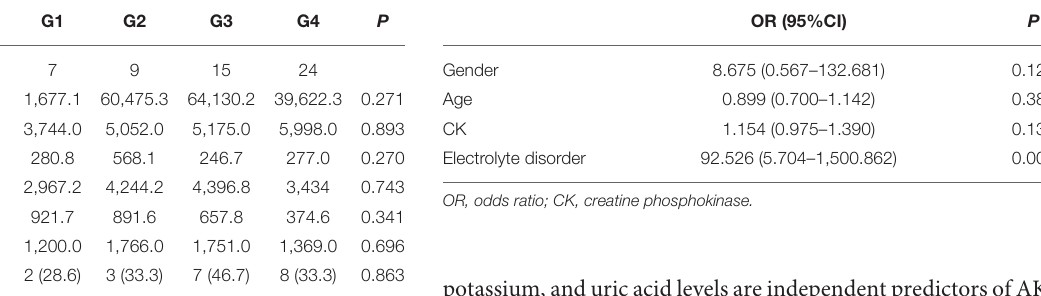
TABLE 4 | Laboratory results for all groups. TABLE 5 | Logistic regression analysis for risk factors for AKI in children with